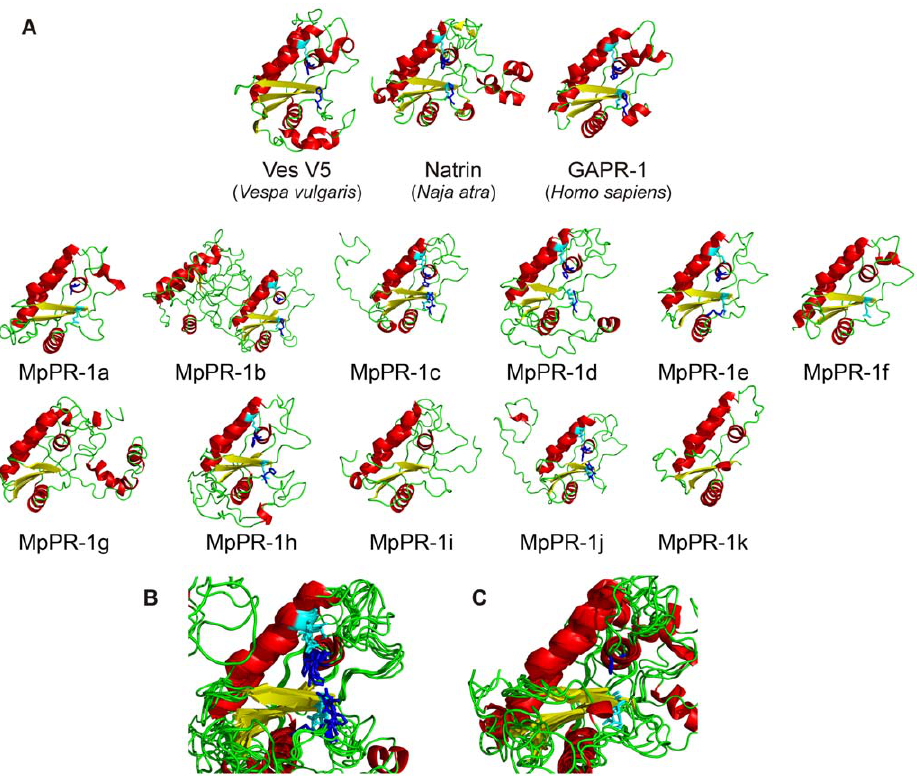
Figure 3. Homology modeling of MpPR-1 proteins. (A) Ribbon stick representation showing the folding of eleven MpPR-1 proteins and three SCP/TAPS proteins used to obtain these models. The putative residues forming the catalytic site are highlighted in dark blue (histidines) and light blue (glutamic acids). Note the presence of an additional protein module in MpPR-1b and MpPR-1g. These modules respectively correspond to the N- terminal and C-terminal extensions observed in these proteins. (B) MpPR-1b, MpPR-1c, MpPR-1d, MpPR-1e, MpPR-1h and MpPR-1j have the four putative active site residues of the SCP/TAPS domain. (C) These residues are partially or completely absent in MpPR-1a, MpPR-1f, MpPR-1g, MpPR-1i and